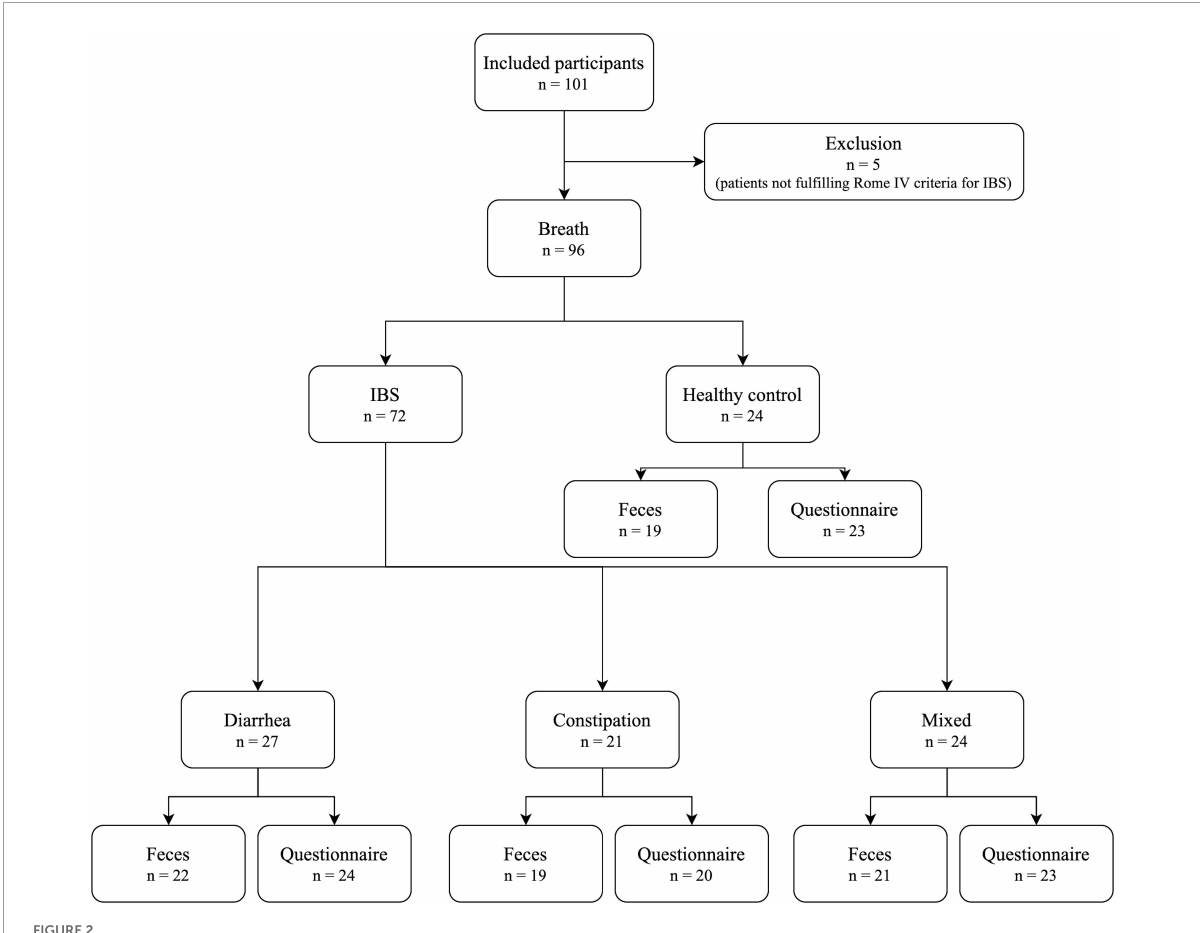
FIGURE2 Flow of study participants; IBS, irritable bowel